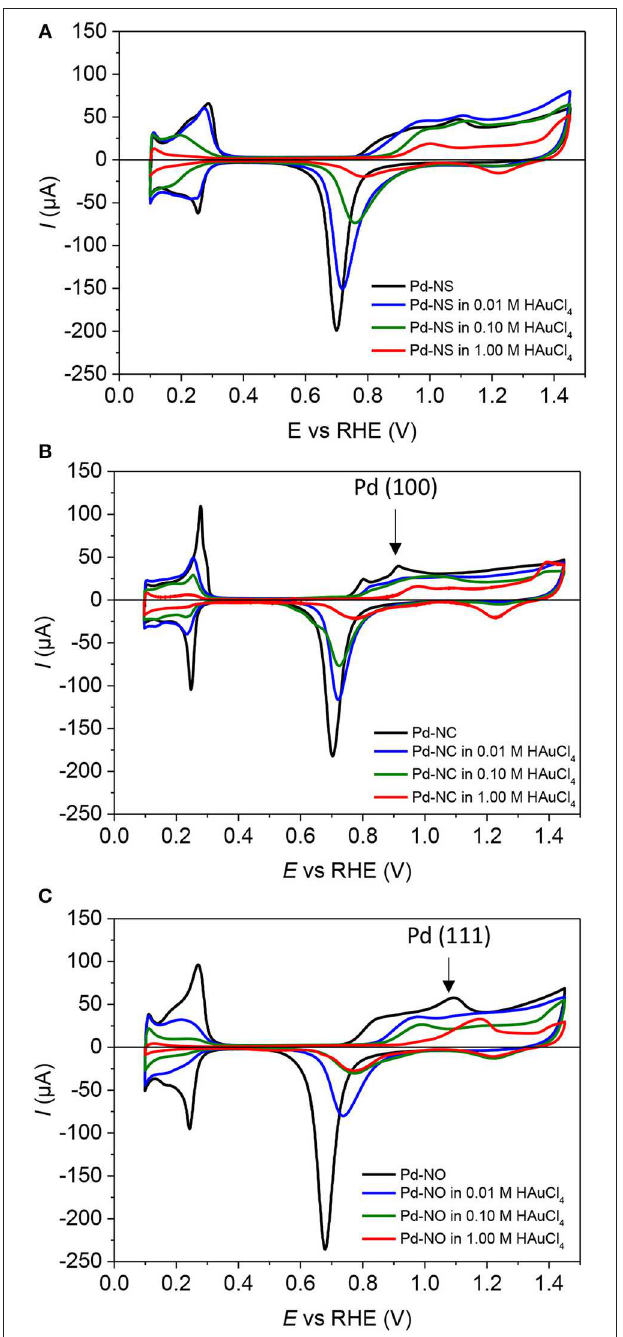
FIGURE 2 | CV profiles in the 0.10–1.45V range obtained in N 2 -purged aqueous H 2 SO 4 0.5M electrolyte (T = 293K, scan rate = 5mV s − 1 ) for (A) Pd-NS (B) Pd-NC, and (C) Pd-NO. – for pure Pd-NPs, – after dipping 1min in